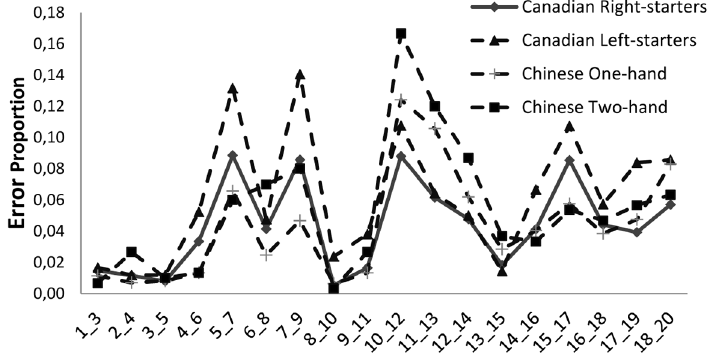
Figure 2. Error proportions across different